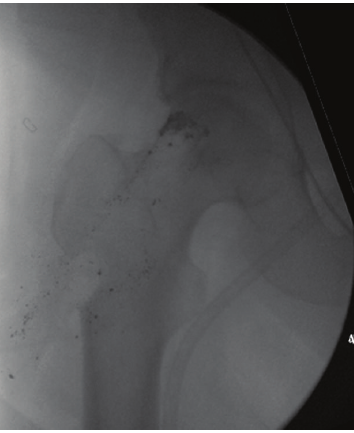
Figure 1: Preoperative pelvis radiograph showing bilateral porous tantalum implants. Figure 2: Postoperative radiograph of right proximal